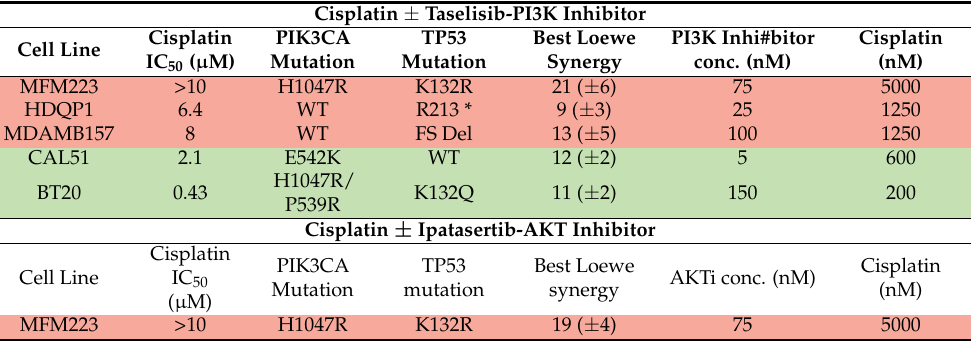
Table 4. Cisplatin-resistant TNBC cell lines that are both PIK3CA and TP53 mutant respond best to the combination of taselisib (PI3K inhibitor) and cisplatin. Further, the MFM-223 cisplatin-resistant TNBC cell lines that is PIK3CA and TP53 mutant has the best response to the combination of ipatasertib (AKTi) and cisplatin. TNBC cells with innate resistance to cisplatin are highlighted in red, whilst TNBC cells with innate sensitivity to ciaplatin are highlighted in green. Standard deviations are calculated from triplicate independent assays. Loewe synergy calculated using Combifit Analysis ™. IC 50 results calculated using the CalcuSyn software ™. Mutational status of TP53 and PIK3CA were obtained from the Cancer Cell Line Encyclopaedia (https://portals.broadinstitute.org/ccle accessed on 15 February